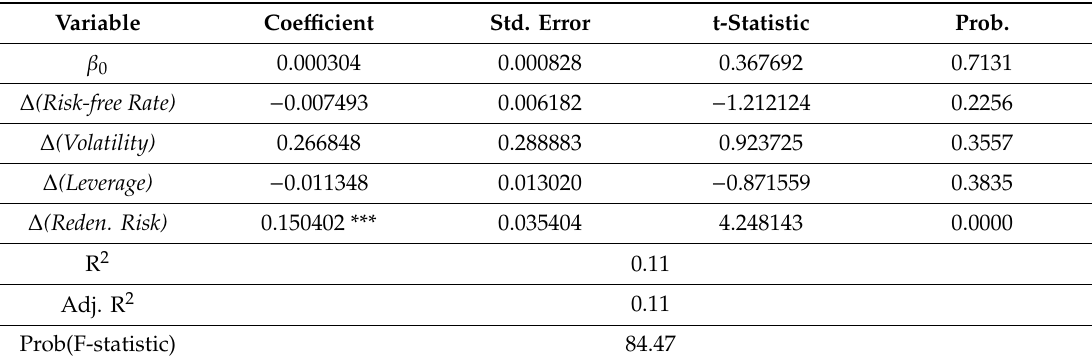
Table A9. Extended model OLS estimates: period August 2007–September 2018 (2751 Obs. after